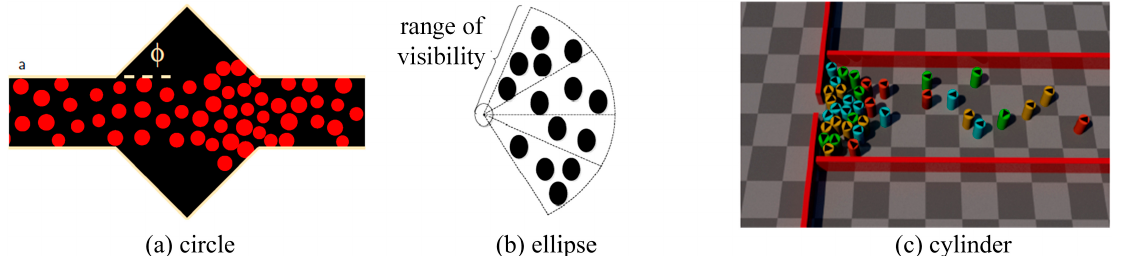
Figure 5. Crowd visualization methods: ( a ) circles with different radii [16]. ( b ) Long axis of ellipse indicates pedestrians’ shoulder widths, and the short axis reveals the body direction [60]. ( c ) The heights of the cylinders indicate the heights of the pedestrians, and the triangles denote the walking direction [17].